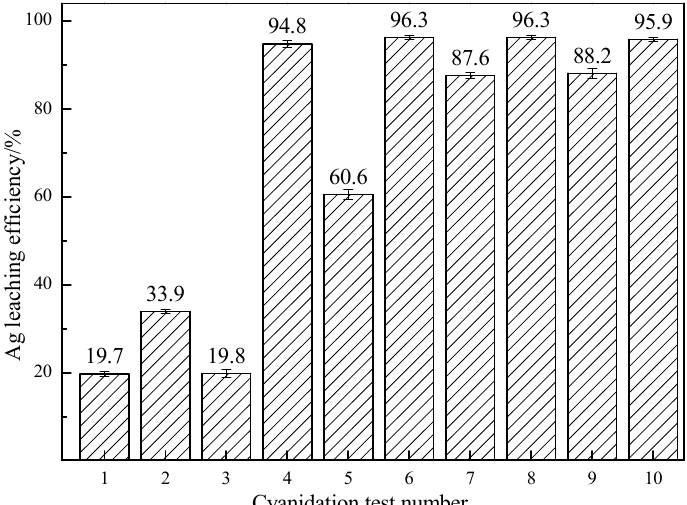
Figure 6. Silver leaching efficiency of different samples: 1. Manganese–silver concentrate; 2. Silver- bearing pyrite; 3. Mixed ore used in single factor test (amount of silver-bearing pyrite addition-level 5); 4. Leaching residual of single factor test (amount of silver-bearing pyrite addition-level 5); 5. Leaching residual of PB test (Run 7); 6. Leaching residual of RSM-CCD test (Run 18); 7. Leaching residual of two-stage method (No. 2); 8. Leaching residual of two-stage method (No. 3); 9. Leaching residual of two-stage method (No. 3-controlled); 10. Leaching residual of two-stage method (No. 4). Table 8. comparison of chemical leaching and two-stage method.